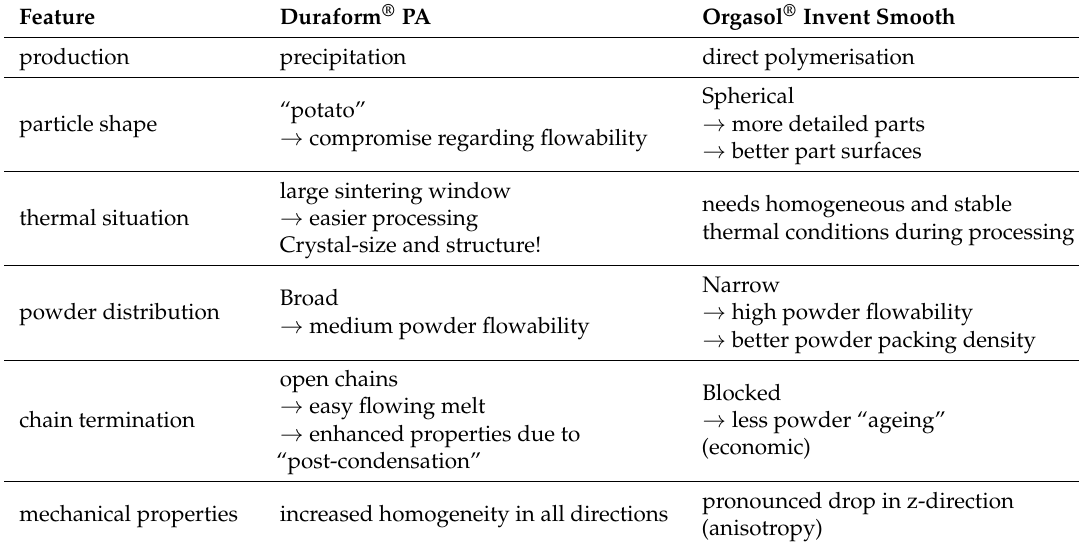
Table 3. Summary of the main features of laser sintering (LS)-powders and characteristic influences on parts and